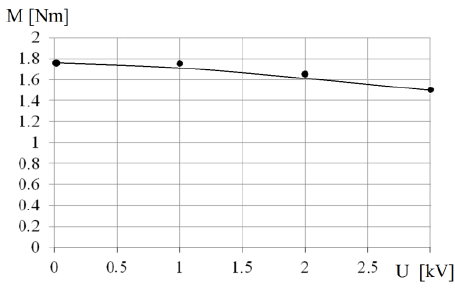
Figure 6. Method of determining the coefficient c : solid line — model, points — test.